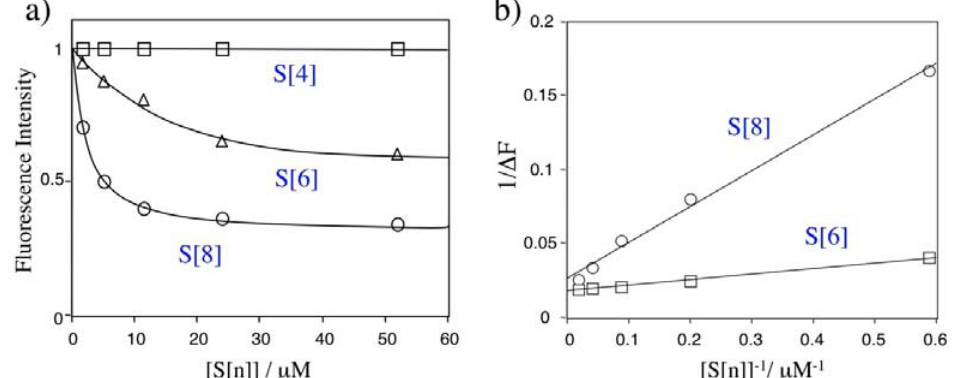
Figure 3. (a) Relative fluorescence intensity of Rh800 (40 nM in PBS) in the presence of S[n]. S[n] (1 mM) was added to the aqueous solution of Rh800 (40 nM) under stirring. (b) Plots of 1/  F versus 1/ [ S